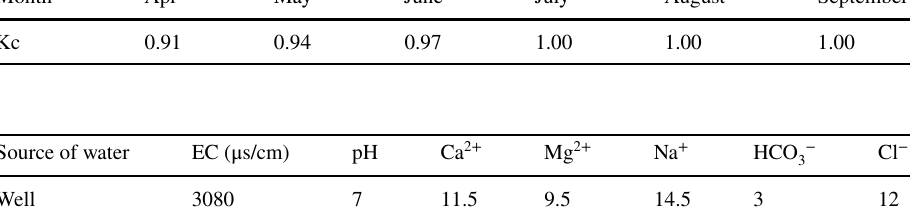
Table 2 Crop coefficient for the date